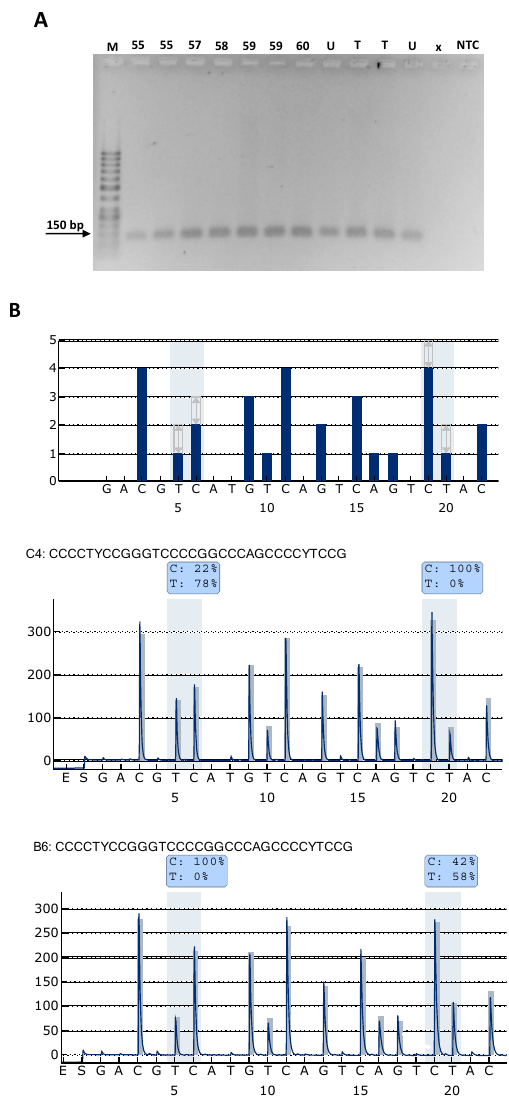
Figure 1. Analyses of T and C allele frequencies for C250T and C228T TPMs by PCR and pyrosequencing. ( A ) Representative result of PCR products analyzed by 2% agarose gel electrophoresis. DNA was isolated from FFPE tumor tissue and cell line controls (U: U87MG, T: T98G) with known T allele frequencies. Numbers indicate the patient IDs from FFPE tumor tissue samples analyzed. M: 50bp DNA marker, NTC: non-target control for PCR, X: empty. ( B ) C250T and C228T TPM detection by pyrosequencing. (top panel) Histogram shows at y-axis the number of nucleotides incorporated and at the horizontal axis the dispensation order with theoretical representation of the expected peak patterns. The grey background with arrows indicates the quantified C and T bases of the two hot spot TPMs C250T and C228T at dispensation order positions 5 / 6 and 19 / 20, respectively. Representative pyrogram results of TPM control cell lines T98G (middle panel) and U87MG (lower panel). Nucleotides were added successively in the pyrosequencing reactions following the sequence to analyze as displayed above the pyrogram. Each adequate nucleotide included generates a light signal shown as a peak. Background signals were obtained by addition of enzyme (E) and substrate (S) of pyrosequencing reaction, and the first control nucleotides G and A that are not present in the sequence to analyze. The peak heights in the pyrogram marked by gray background reflect the ratio of cytosine (C) to thymine (T) at each hot spot TPM and are used for calculation of C and T allele frequencies shown in blue boxes for C250T (left) and C228T